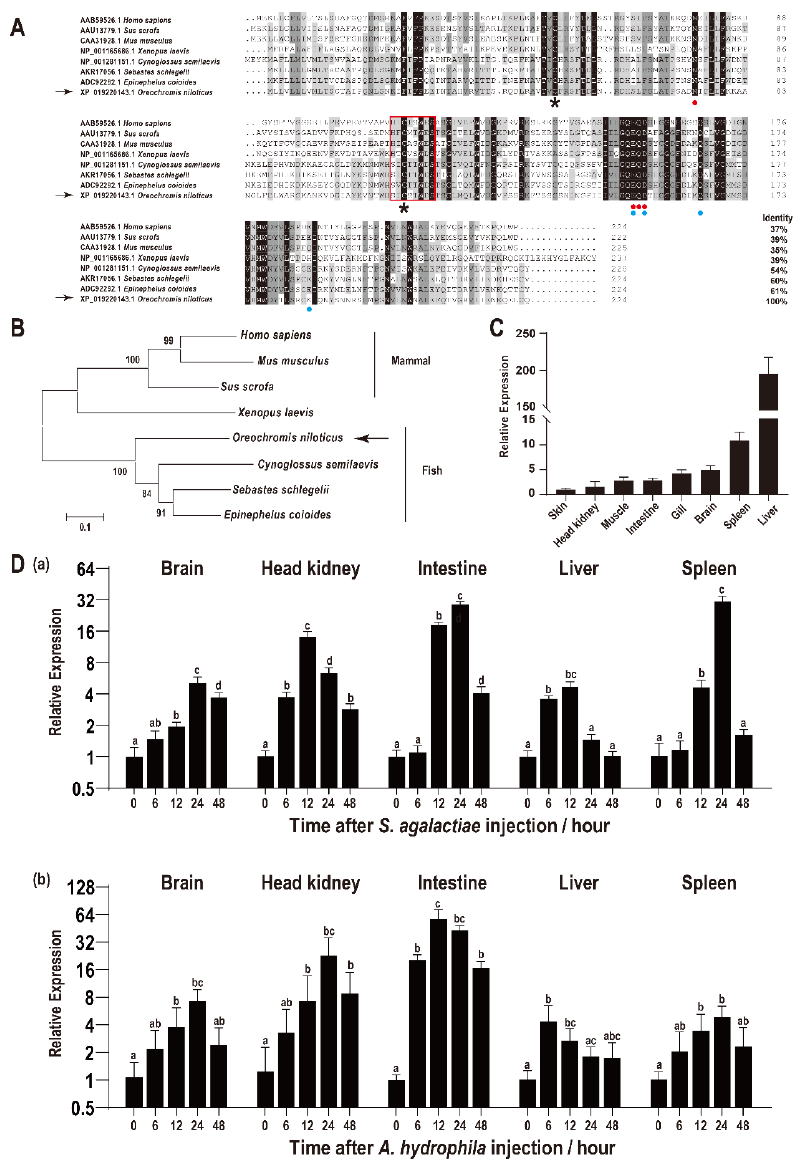
Figure 1. ( A ) Multiple sequence alignments of CRP among different species. The percentage value following each amino acid sequence indicates overall sequence identity between On-CRP and other sequences. Similar residues are marked in grey and consensus residues are marked in black. The red box indicates the PTX domain. The asterisks below the alignment indicate the two conserved cysteine residues. The two calcium ion binding sites were indicated by red points (site 1) and blue points (site 2), respectively. ( B ) Phylogenetic tree of On-CRP among different species constructed using the neighbour-joining method. The numbers at the nodes between the branches point to the bootstrap confidence values with 1000 replicates. ( C ) Relative expression levels of On-CRP mRNA among different tissues in healthy Nile tilapia were assessed via qRT-PCR. All values are the mean ± SD; n = 3. The expression level of On-CRP in the skin was set as 1. ( D ) Expression patterns of On-CRP mRNA in different tissues (brain, head kidney, intestine, liver and spleen) at a series of time points after S. agalactiae ( a ) and A. hydrophila ( b ) injection as detected via qRT-PCR. The expression level of On-CRP at 0 h was set as 1.00 to calculate the relative expression of the other time points. All values are the mean ± SD, n = 3. Different letters indicate significant difference ( p <